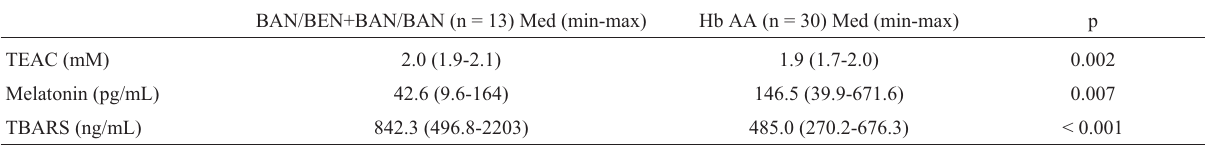
Table 5 - Antioxidant capacity and lipid peroxidation in Bantu and Benin haplotypes as compared to the control group (Hb AA).